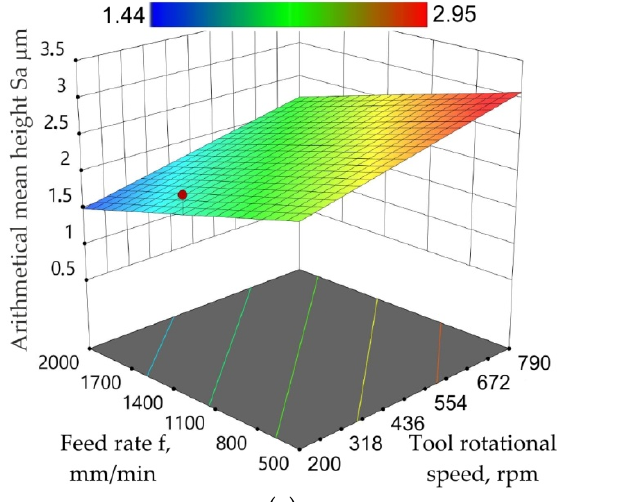
Figure 13. Normal probability plot of residuals for the Sa parameter measured on the ( a ) inner and ( b ) outer side of the drawpiece.